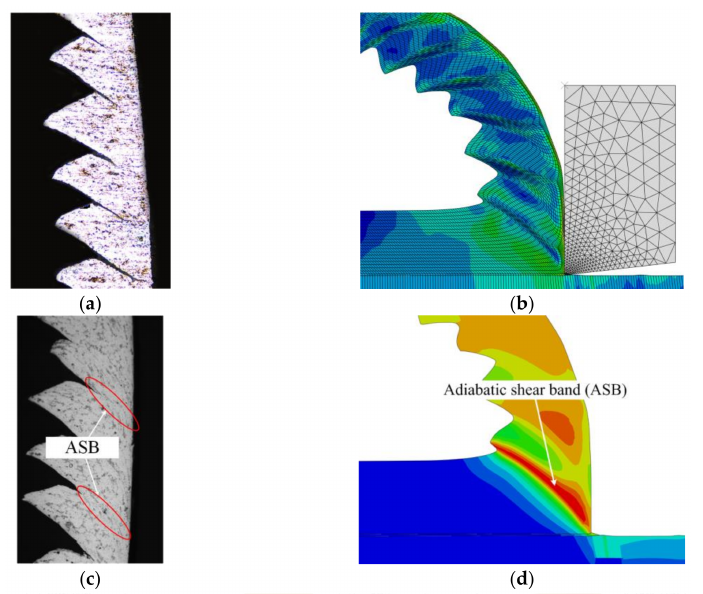
Figure 12. Chip morphology analysis: ( a , c ) experimental result; and ( b , d ) the finite element method (FEM) simulation result. Table 8. Relative errors of chip geometrical characteristics between the experiment and